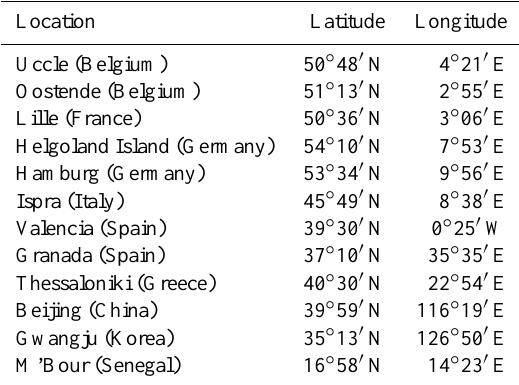
Table 2. List of places mentioned in this article with their latitude and